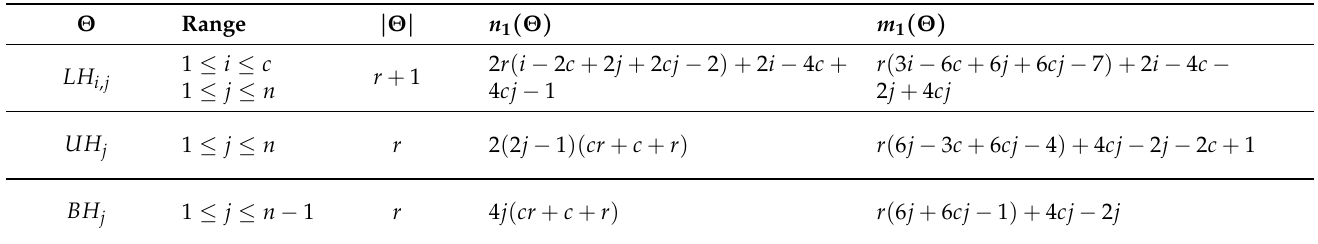
Table 1. H-type Θ -classes of WNR ( r , c , n ) .